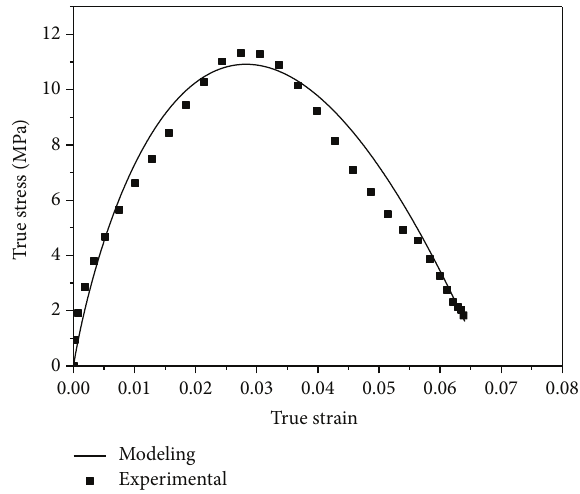
Figure 5: Comparison of model predictions and experimental results at 20 ∘ C (specimen’s density is 1.7 g/cm 3 , strain rate is 800 s −1